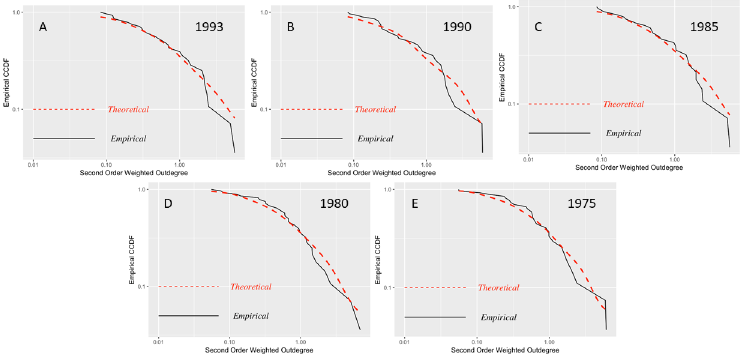
Fig 8. CCDF second-order weighted outdegree input-output matrices 1975–1993. (A) Matrix 1993, 34 economicsectors. (B) Matrix 1990, 34 economicsectors. (C) Matrix 1985, 34 economicsectors. (D) Matrix 1980, 34 economicsectors. (E) Matrix 1975, 34 economicsectors. Log-logplots of the empiricalcounter- cumulative density functions of the weightedsecond-order